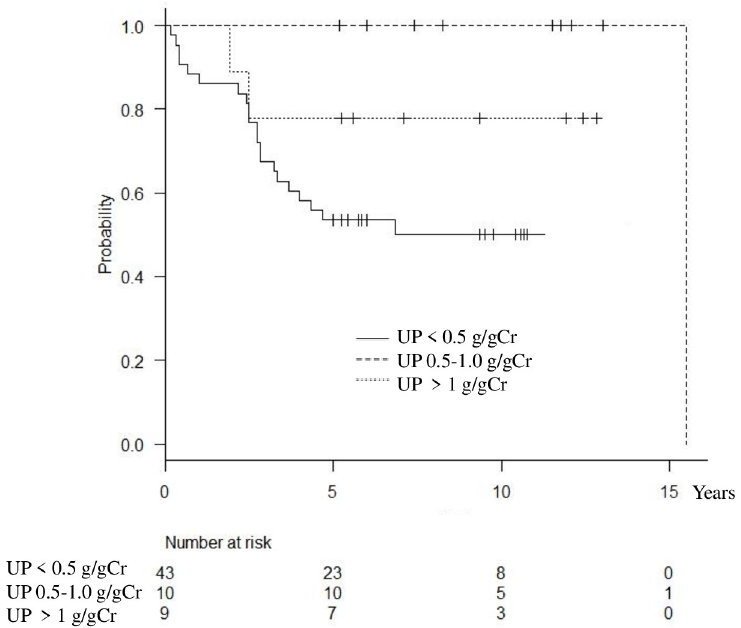
Fig 2. Kaplan-Meier plot of proteinuria remission, defined by persistent proteinuria of < 0.3 g/gCr.